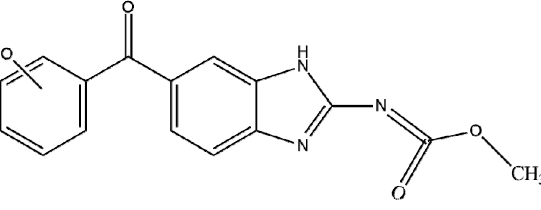
Figure 5. Proposed structure of the newly formed compound.